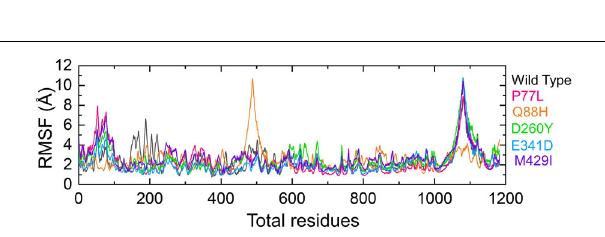
FIGURE 7 | Residual flexibility of the NSP13 WT and mutant complexes calculated as root mean square fluctuation (RMSF). The RMSFs of WT are represented in black, while different colors are used for mutants. RMSF, root mean square